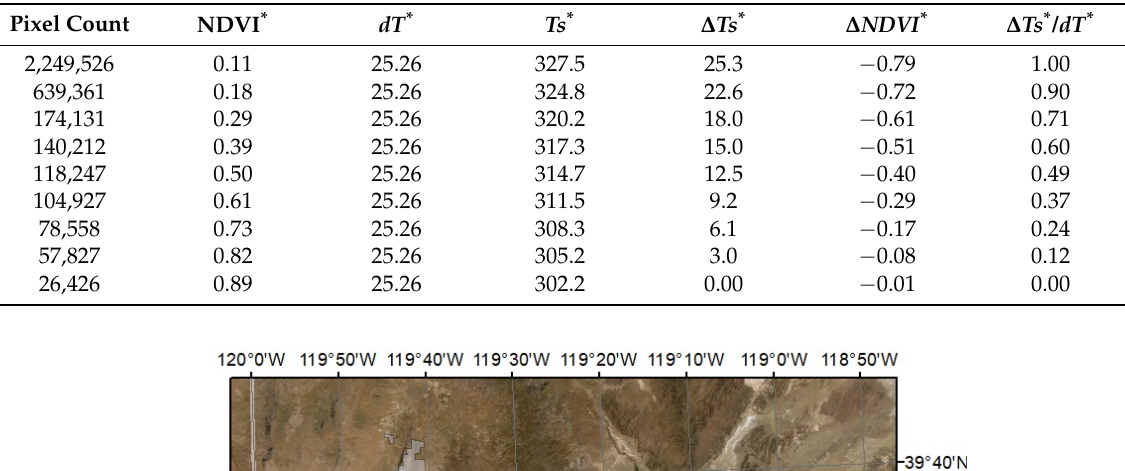
Table 1. Spatial-average values for Landsat NDVI and Ts, and dT parameters corresponding to the 1 July 2020, image. Pixel count refers to the number of 30 m pixels for each parameter. The * indicates spatial averages for each NDVI bin.